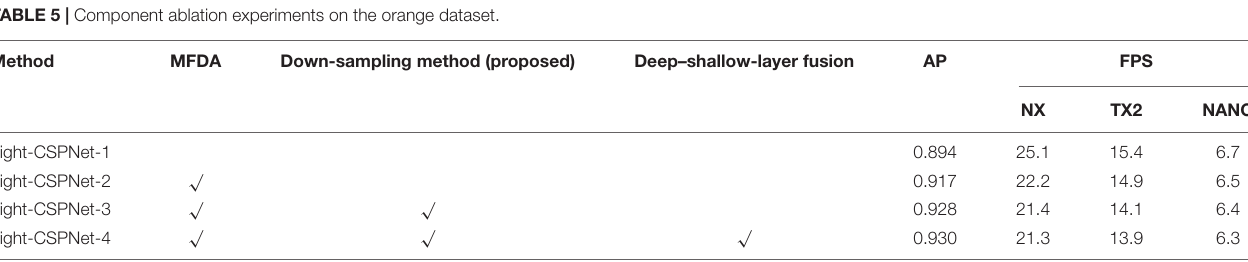
TABLE 5 | Component ablation experiments on the orange